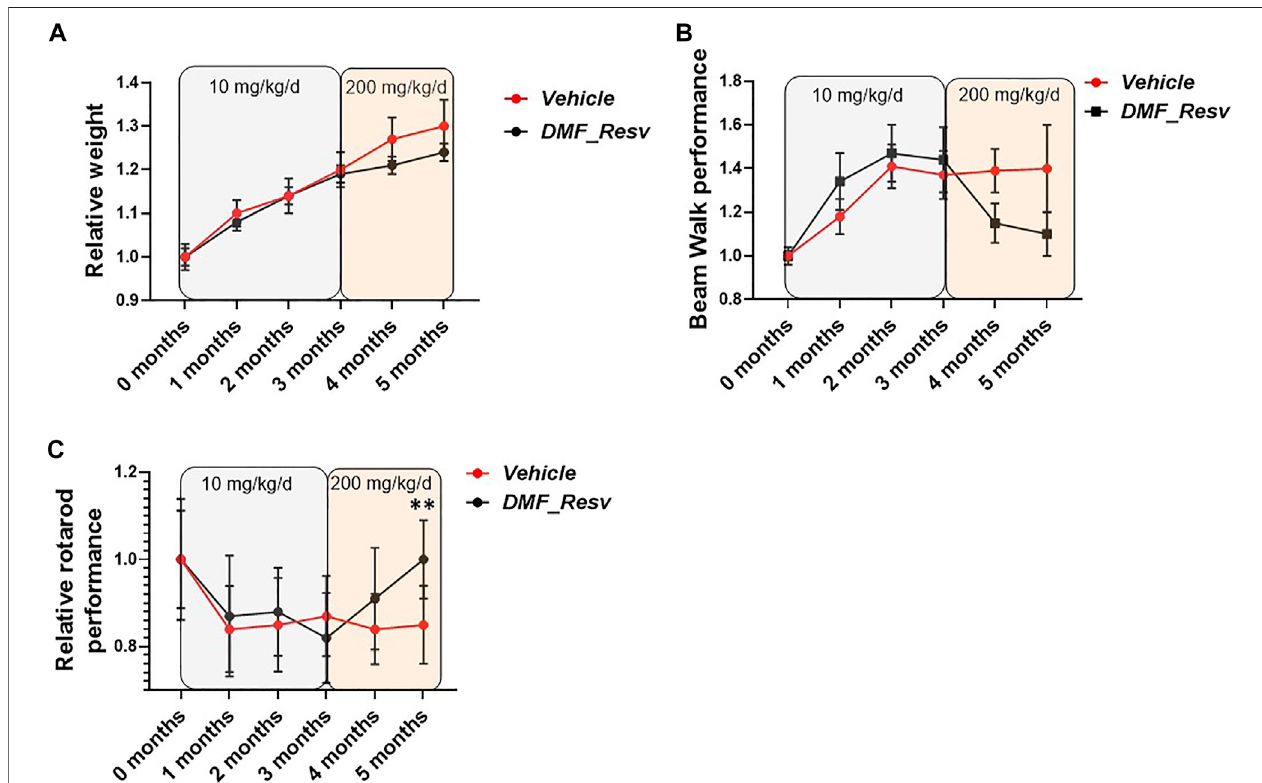
FIGURE 5 | FA mice performance during the trial. YG8LR mice performances were measured compared between two groups: 1. vehicle and 2. DMF and Resv combination. (A) The relative weight did not show differences between treated and vehicle mice, and no differences were detected after changing the concentration of the administered drugs (from 10 mg/kg/d to 200 mg/kg/d). (B) The beam walk analysis showed an improvement but did not achieve statistical signi fi cance. (C) Interestingly, therotarod performance showed asigni fi cant increase after theincreased concentration ofthe drugs. Mean ± SEM, ** p < 0.01 statistical signi fi cance obtained by Student ’ s t test analysis of 5-month data ( Supplementary Table S1